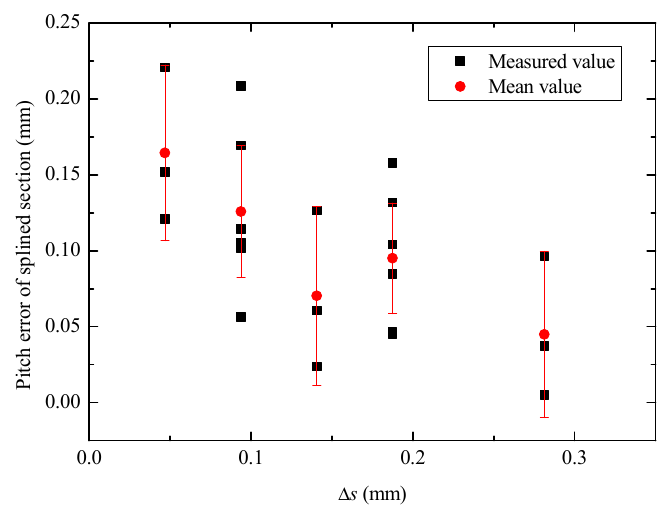
ff erent compression